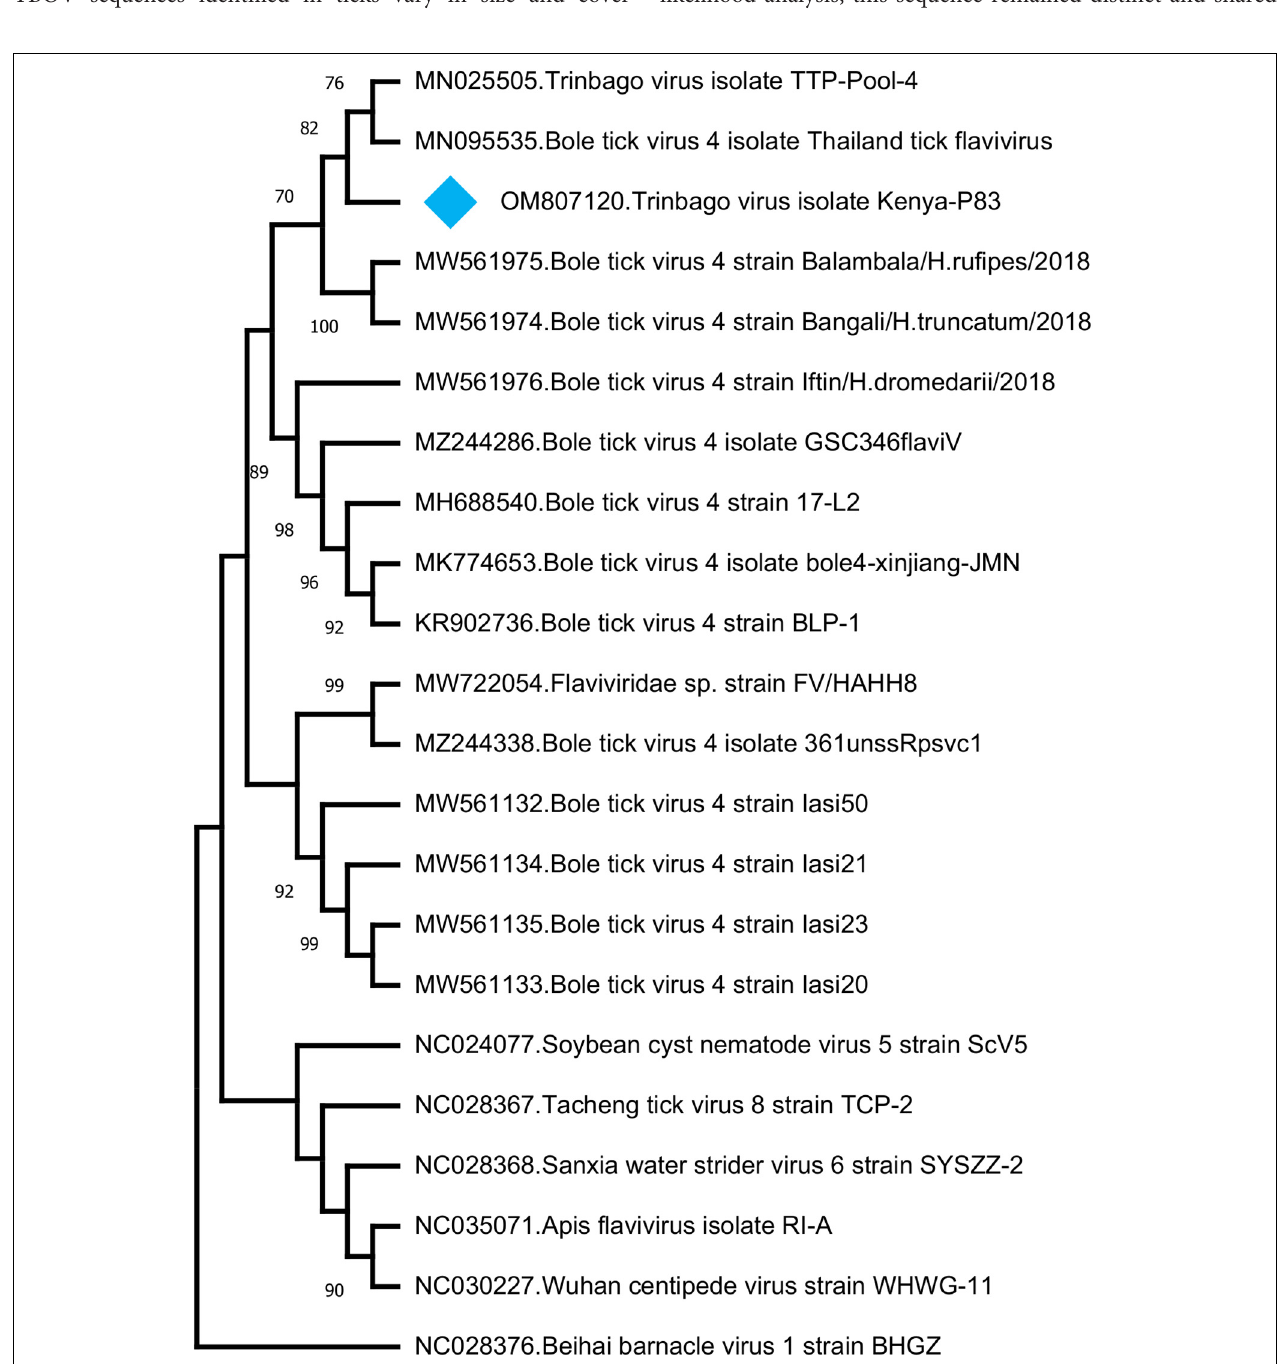
FIGURE 4 | The maximum likelihood analysis of the Trinbago virus partial genome sequences (1,141 nucleotides). The tree is constructed using a gamma-distributed Kimura 2-parameter model for 500 replications. Viruses included in the analysis are indicated by GenBank accession number, name and isolate/strain identifier. Trinbago virus isolate Kenya-P83 characterized in this study is marked (GenBank accession: OM807120). Beihai barnacle virus 1 strain BHGZ is included as the outgroup.